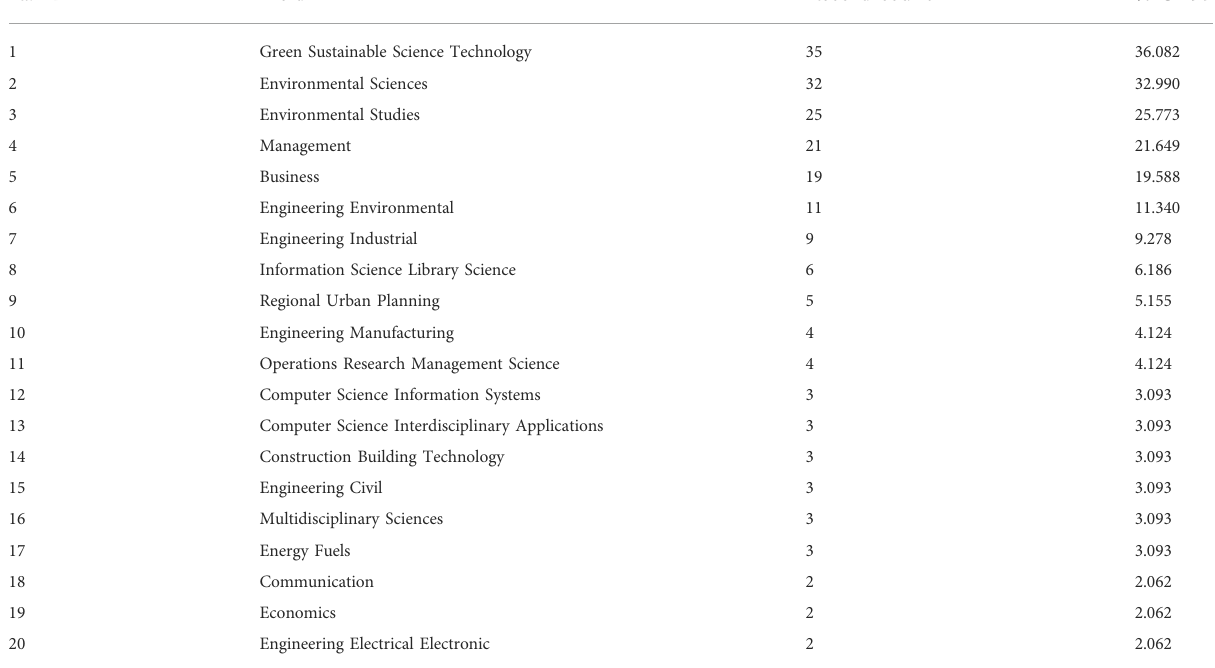
TABLE 1 Top20 research fi elds of